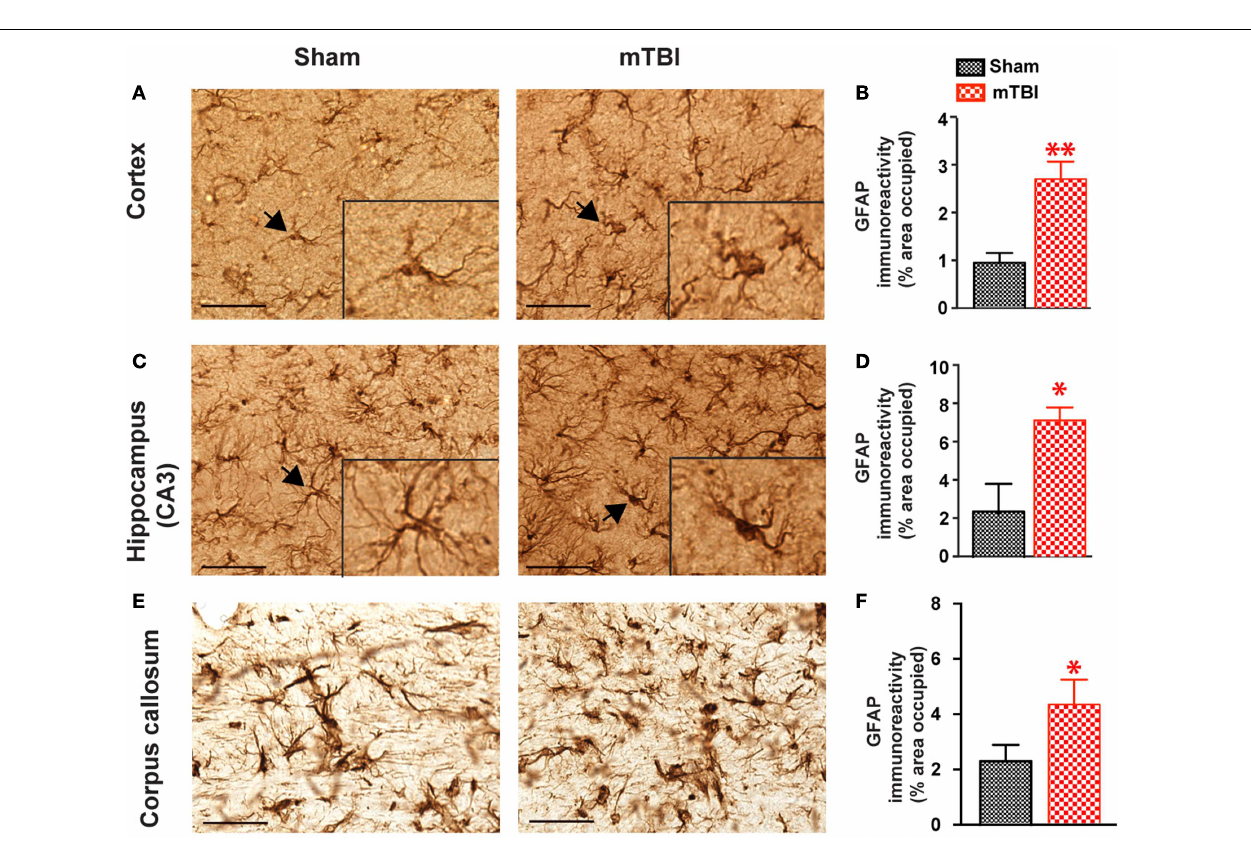
hippocampus (C) , and corpus callosum (E) , and GFAP immunoreactivity (B,D,F) was quantified as percentage of area occupied. Scale bar in (A,C) = 20 µ m. Insert in (A,C) shows a high-magnification view of an astrocyte (arrow). n = 8 (sham) and 15 (mTBI) mice/group. Mean ± SEM. * P < 0.05; ** P < 0.01, by t